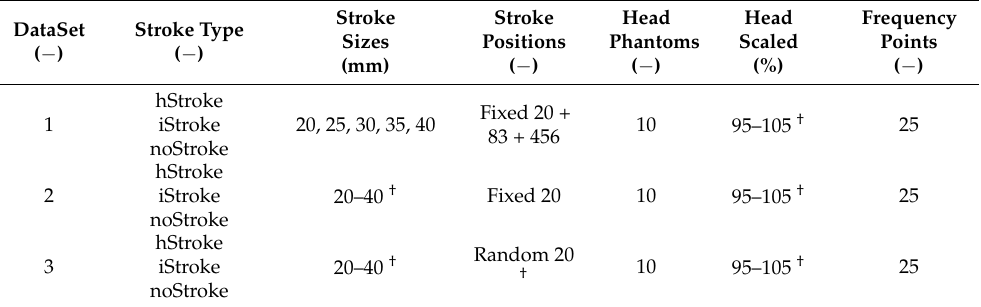
Table 2. Model parameters in the